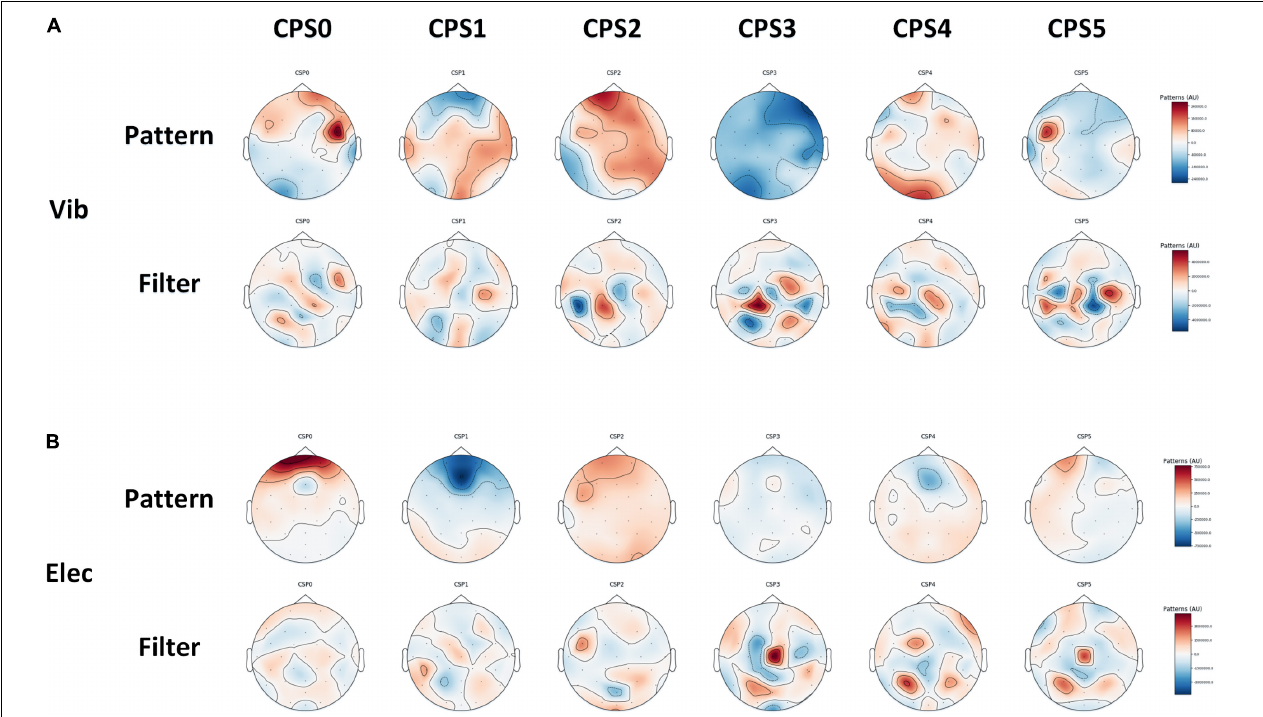
FIGURE 8 | Six spatial patterns and corresponding spatial filters on average of all subjects we choose using CSP, which can be used to extract spatial features from the brain: (A) the vibration task, (B) the electrical task.